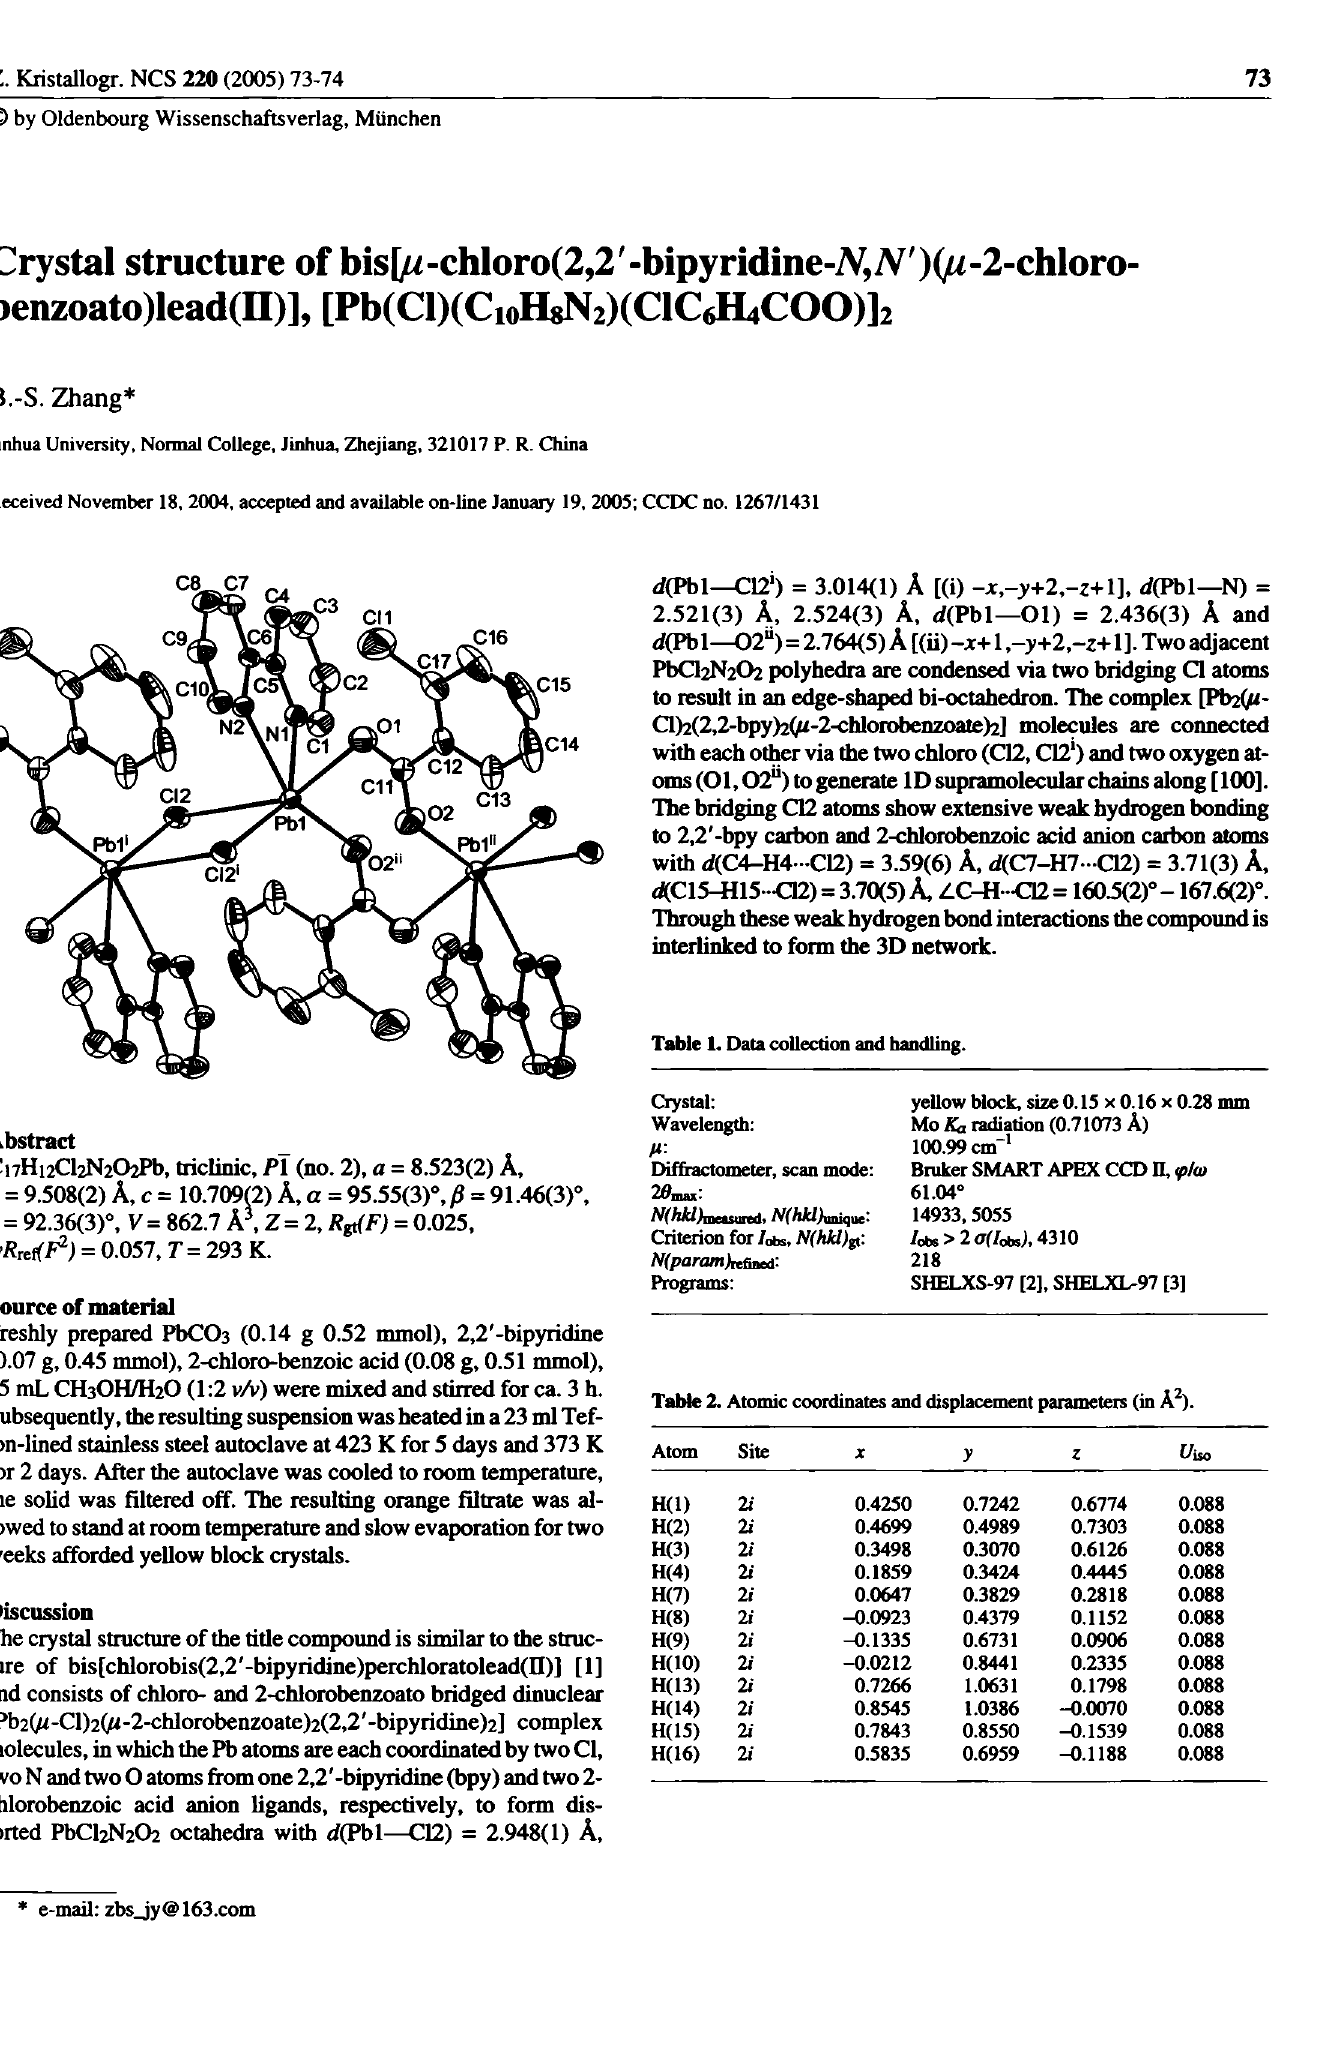
Table 2. Atomic coordinates and displacement parameters (in A 2